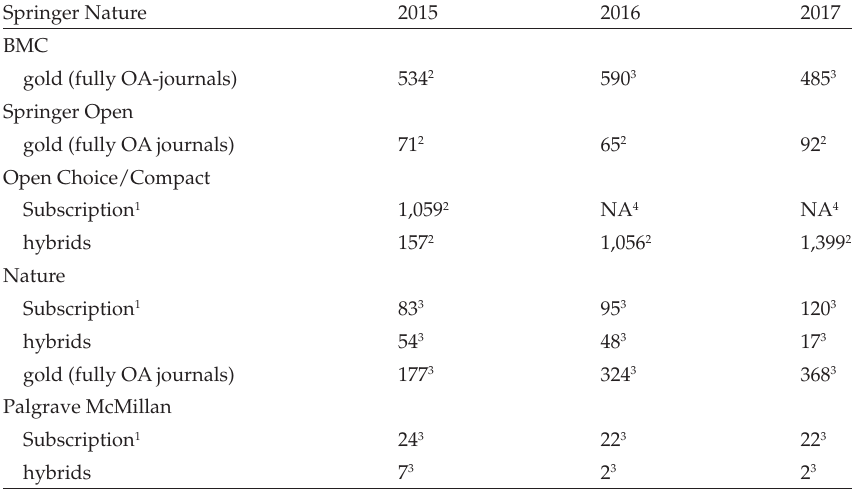
Table 4. Articles and reviews published by Bibsam corresponding authors with Springer Nature 2015–2017. The numbers are to be regarded as preliminary due to data quality.